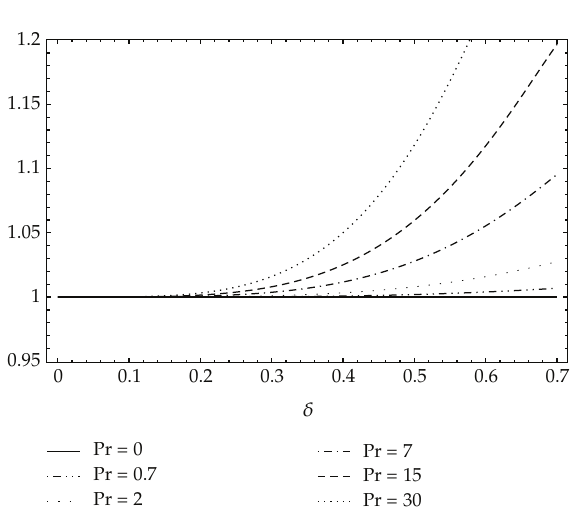
Figure 8: The Nusselt number (cid:3) δθ (cid:2) (cid:3) 0 (cid:4)(cid:4) obtained by the 8th-order approximation of the HPM for di ff erent values of the Prandtl